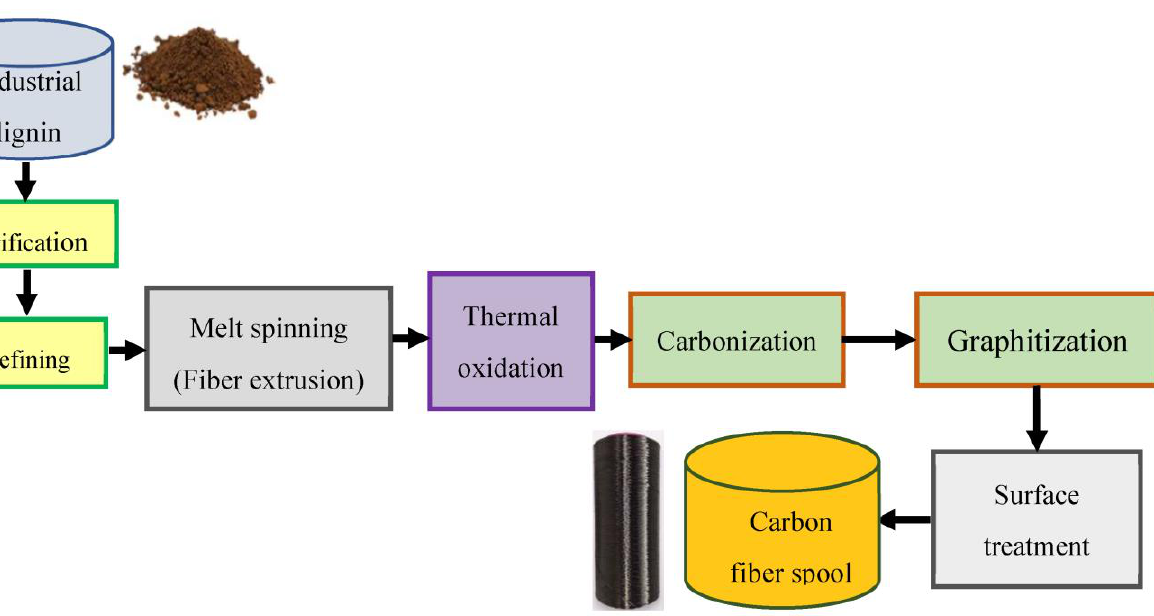
Figure 3. Carbon fiber production using petroleum pitch precursor.